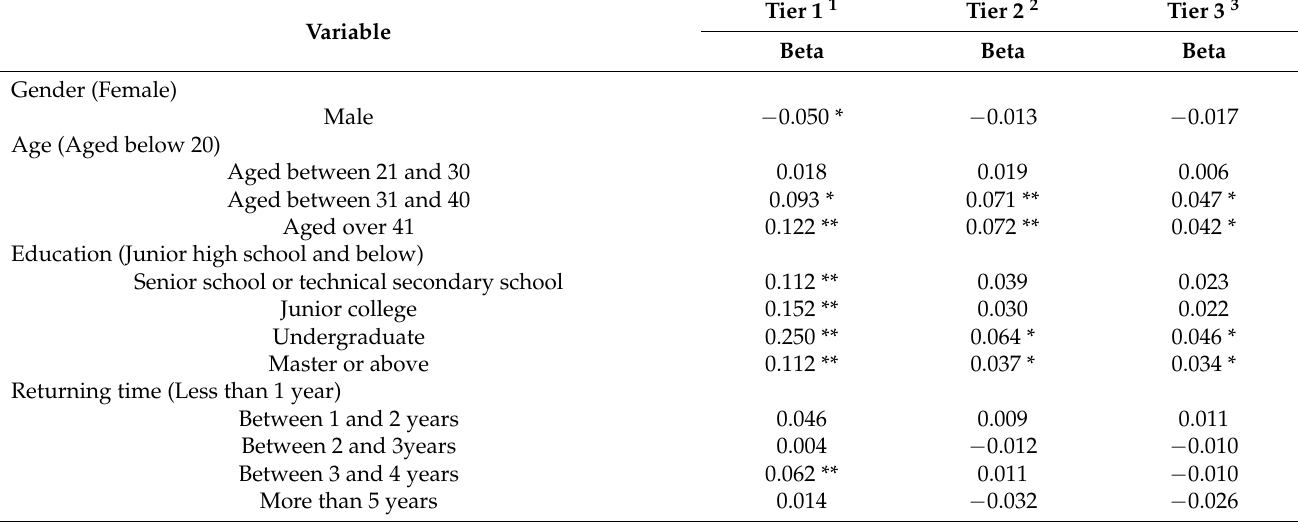
Table 5. Hierarchical linear regression results for urban young returnees’